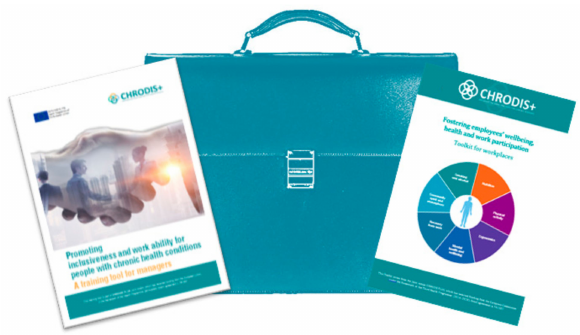
Figure 1. Cover of Toolbox for employment and chronic